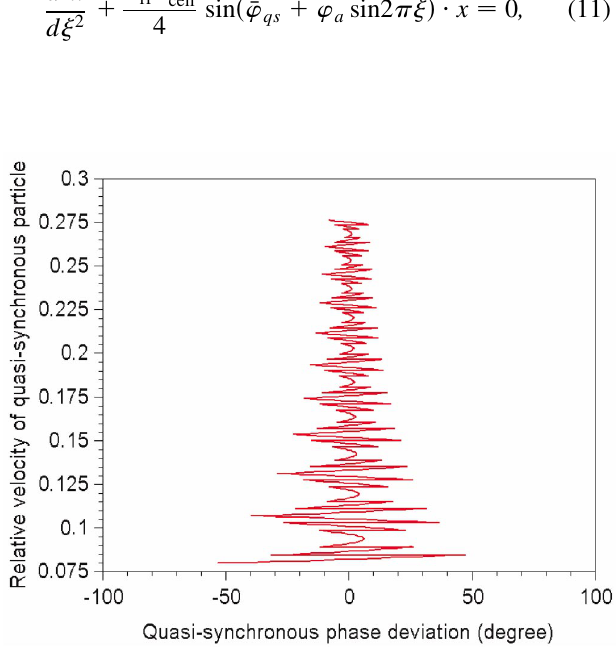
FIG. 2. (Color) Quasisynchronous particle oscillation f (cid:1) (cid:28) (cid:2) (cid:4) (cid:1) (cid:28) (cid:2) (cid:7) ’ ’ relative to the average value in the linear accel- qs qs erator with 10 families.